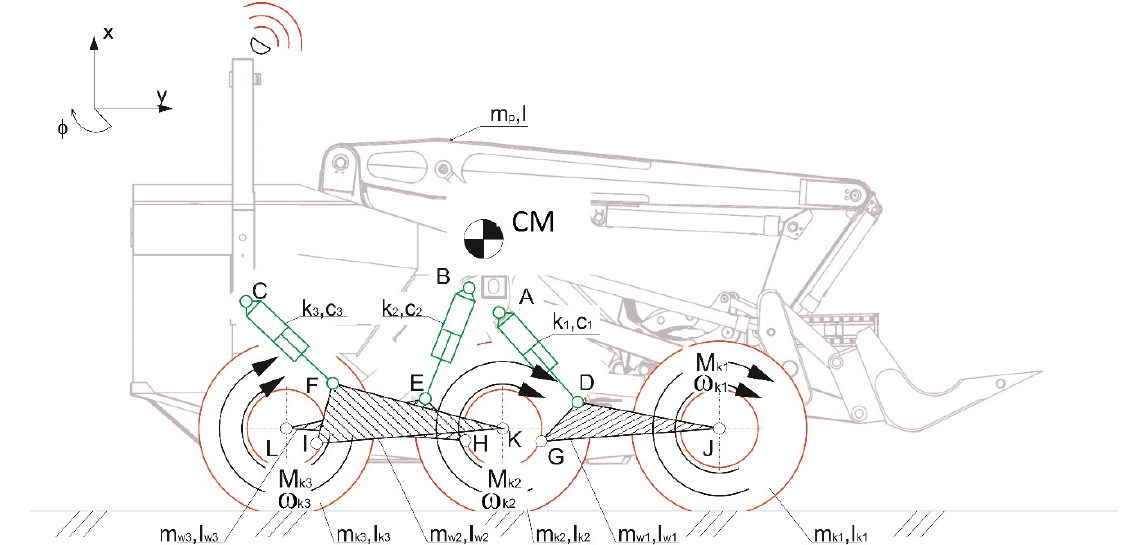
Figure 4. Structure and main parameters of half-vehicle multi-body model [14]: m/I—Mass/mass moment of inertia of vehicle, suspension arms and wheels; M—torque, ω —rotational velocity; k,c—stiffness and damping; A-K—kinematic joints. Table 1. Values of main vehicle body parameters